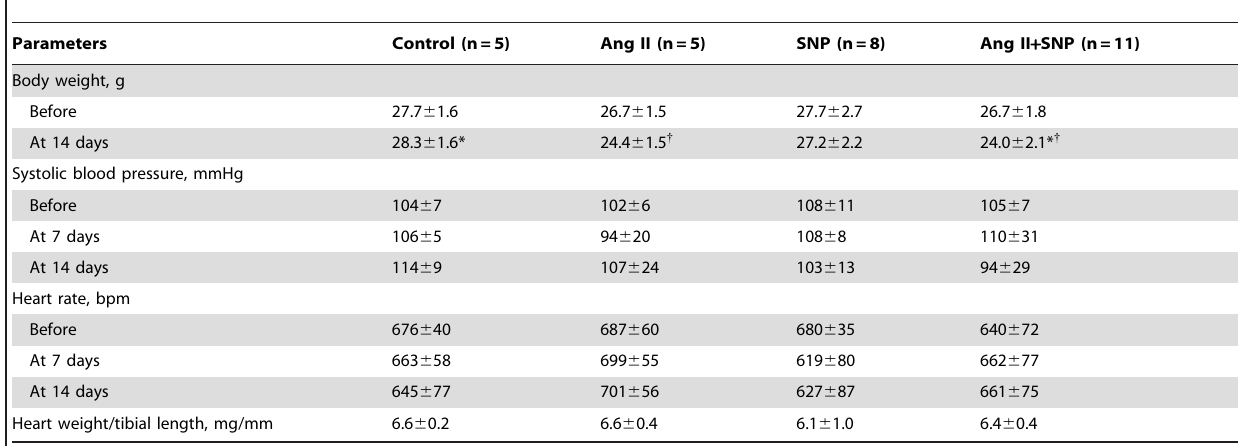
Table 1. Body Weight, Systemic Hemodynamics and Heart Weight/Tibial Length in Control, Ang II-infused, SNP-infused, and A combined Ang II and SNP-infused